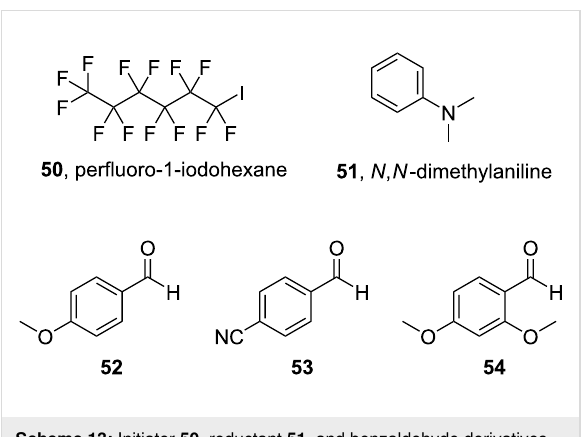
benzaldehyde derivatives tested are presented in Scheme 13 and included 4-anisaldehyde ( 52 ), 4-cyanobenzaldehyde ( 53 ), and 2,4-dimethoxybenzaldehyde ( 54 ), all three of which showed strong absorption bands below 340